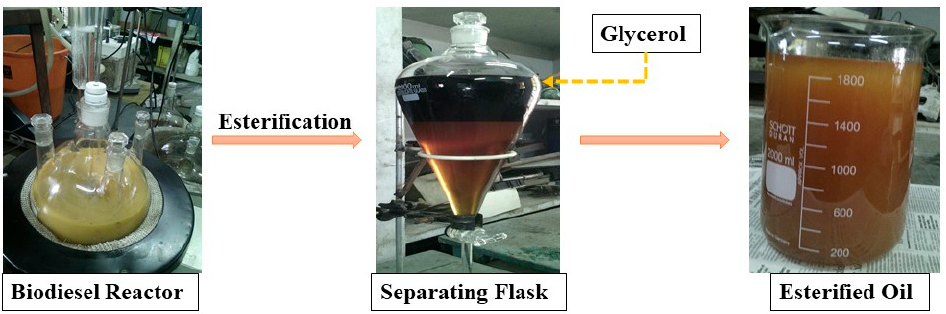
Figure 4. Esterified castor oil.